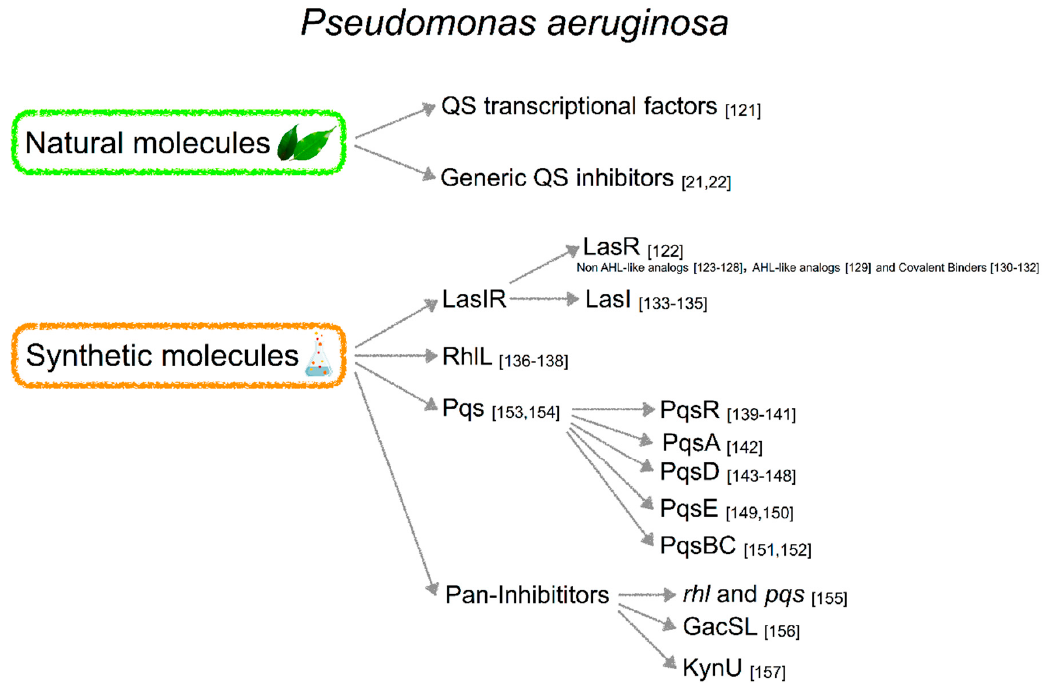
Figure 5. Targets of natural and synthetic molecules active against P. aeruginosa quorum sensing.